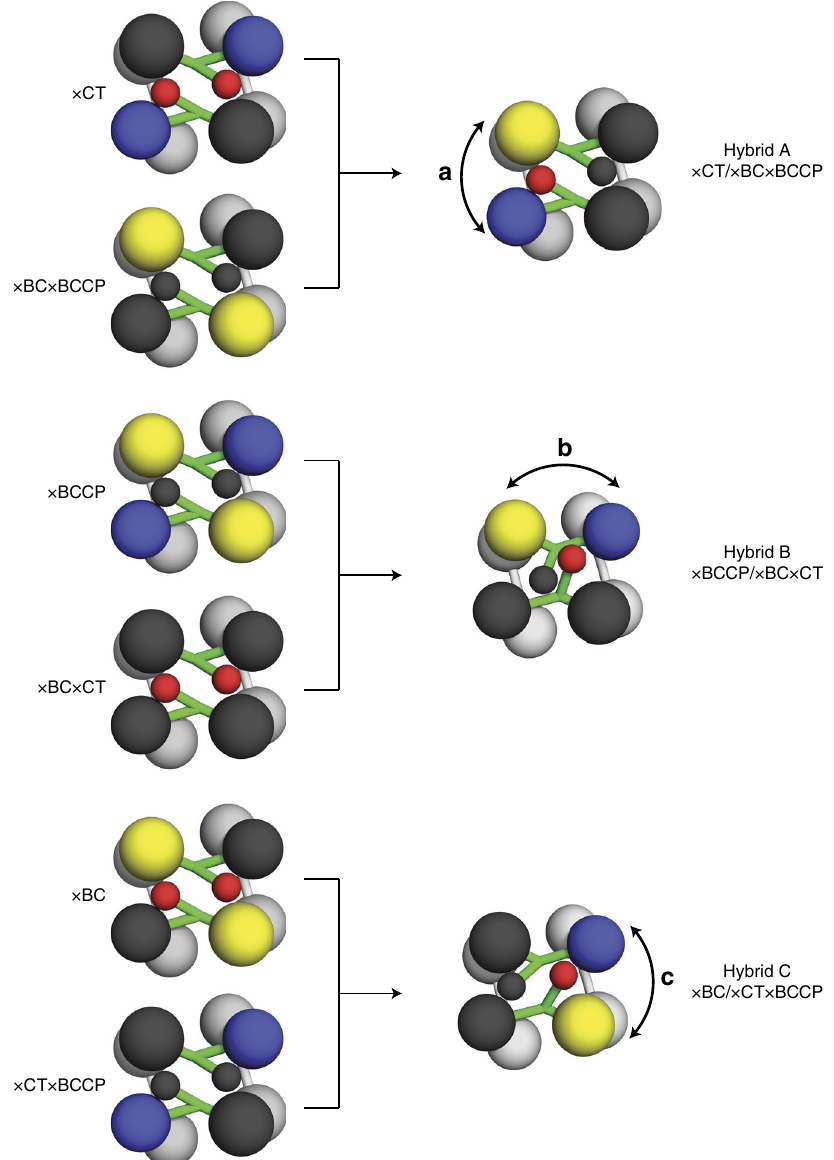
Fig. 4 Design of hybrid tetramers to probe BCCP translocation. A schematic of the three hybrid tetramers (A-C) designed to probe the three speci fi c intermolecular BCCP domain translocation pathways ( a – c ) in